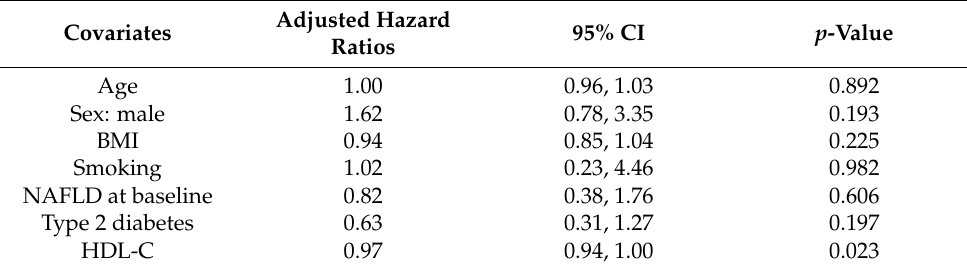
Table 4. Cox proportional hazards regression model with time-varying covariates for atherosclerotic cardiovascular disease